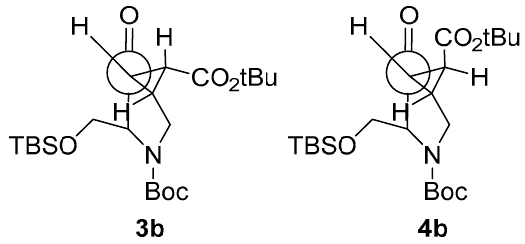
Figure 4. The Felkin-Anh model for compounds 3b and 4b .